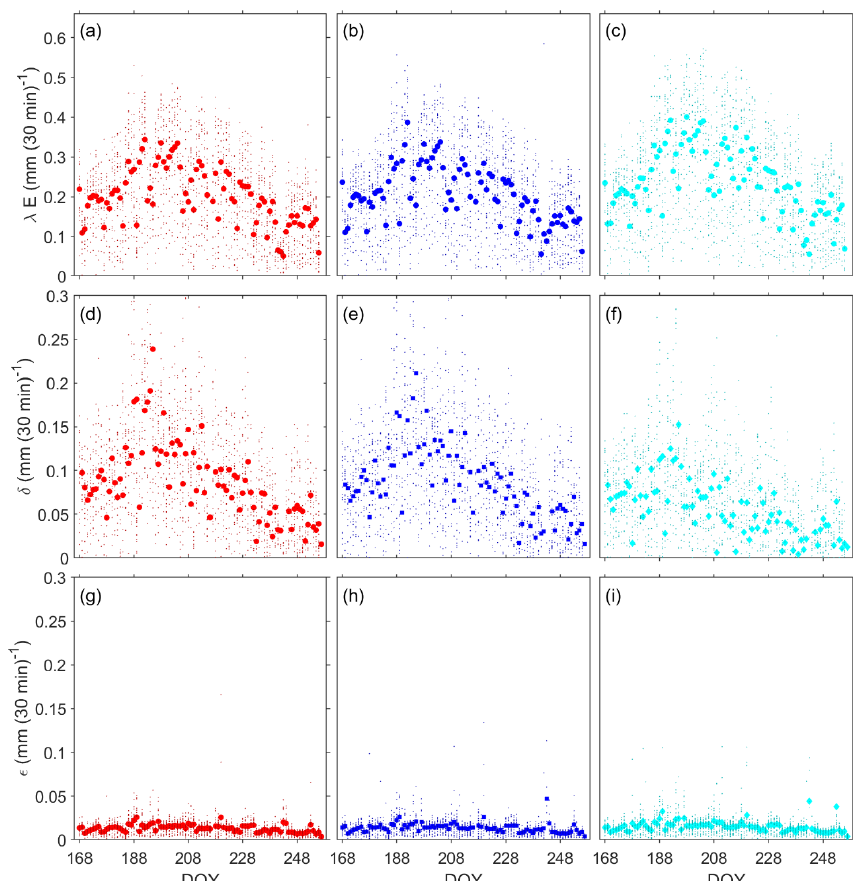
Figure 8. Daytime (09:00–19:00LST) ET fluxes for EC systems with (a) LI-7500RS, (b) LI-7500A, and (c) LI-7500 and the accompanying systematic errors (d–f) and random errors (g–i) . Mean values are displayed as larger